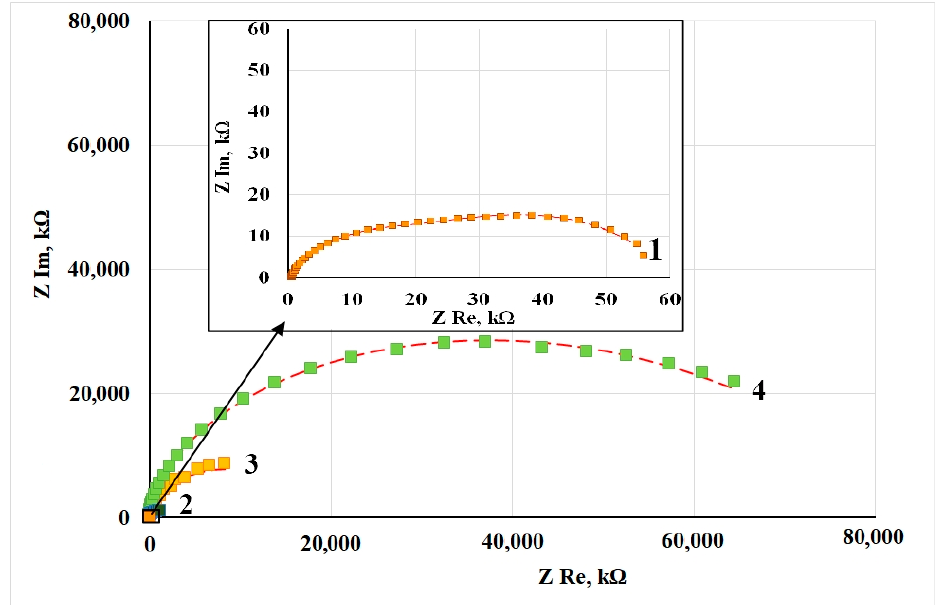
Figure 5. Nyquist plots of brass samples after TT without a CIN (1) and after CT in the vapors of BTA (2), ODA (3) and ODA + BTA (4). Table 12. The values of equivalent circuit elements based on the results of impedance spectroscopy calculated for different variants of brass CT. T CT = 120 °C, and τ CT = 60 min.